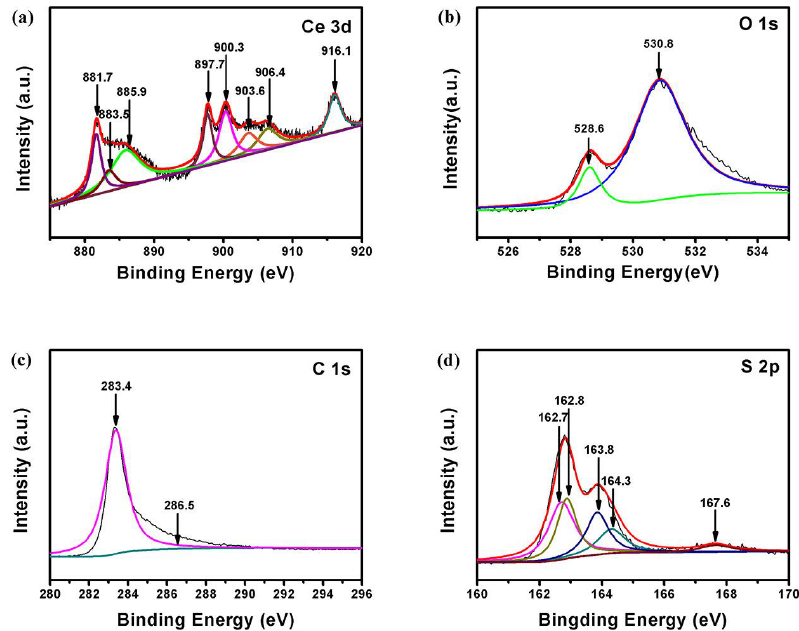
Figure 6. X-ray photoelectron spectroscopy (XPS) binding energy spectra of the core level of ( a ) Ce, ( b ) O, ( c ) C and ( d ) S in the resulting samples.